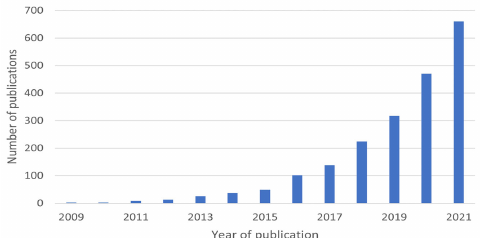
Figure 1. Documents published from 2009 to 2021 under the search criterion [TITLE-ABS-KEY (“biochar” AND “wastewater”)].